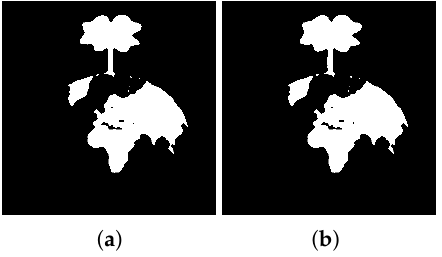
Figure 25. Extracted regions for d = 50 and different values of k ( a ) k = 3; ( b ) k =